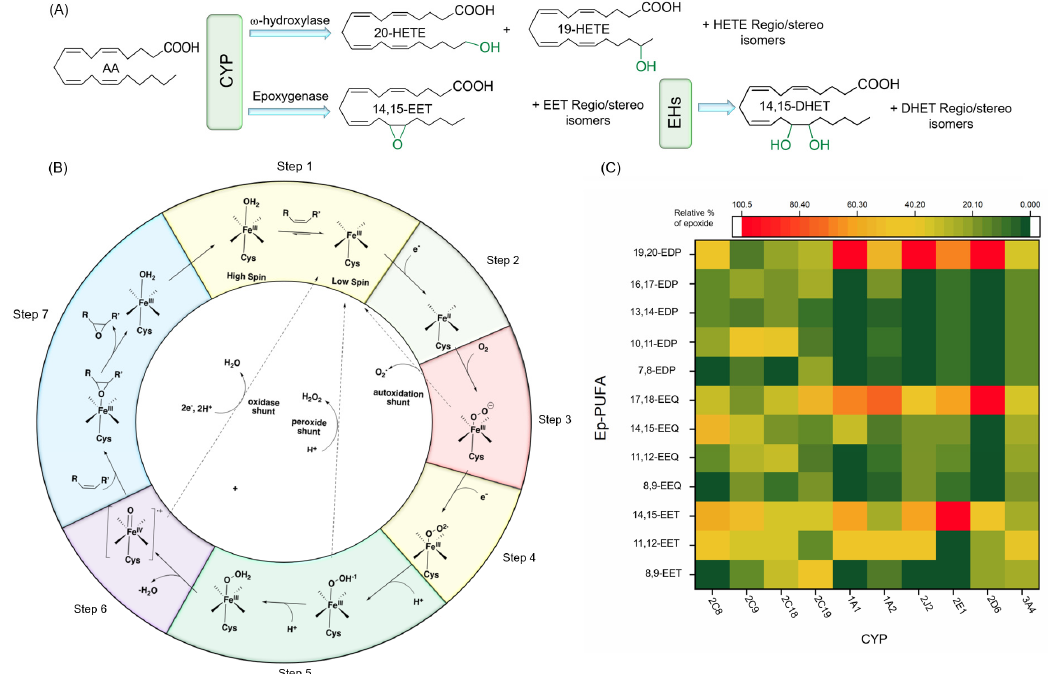
Figure 3. ( A ) CYP hydroxylase and epoxygenase activities on AA, as well as EH products of EETs. ( B ) CYP mechanism of function for monooxygenase activity. ( C ) Regioselectivity in epoxygenase activity of different CYP adapted from [88]. Note that all EETs and HETEs (except 20-HETE) can be exist as either the R- or S-enantiomers. Abbreviations- AA: arachidonic acid, CYP: cytochrome P450, DHET: